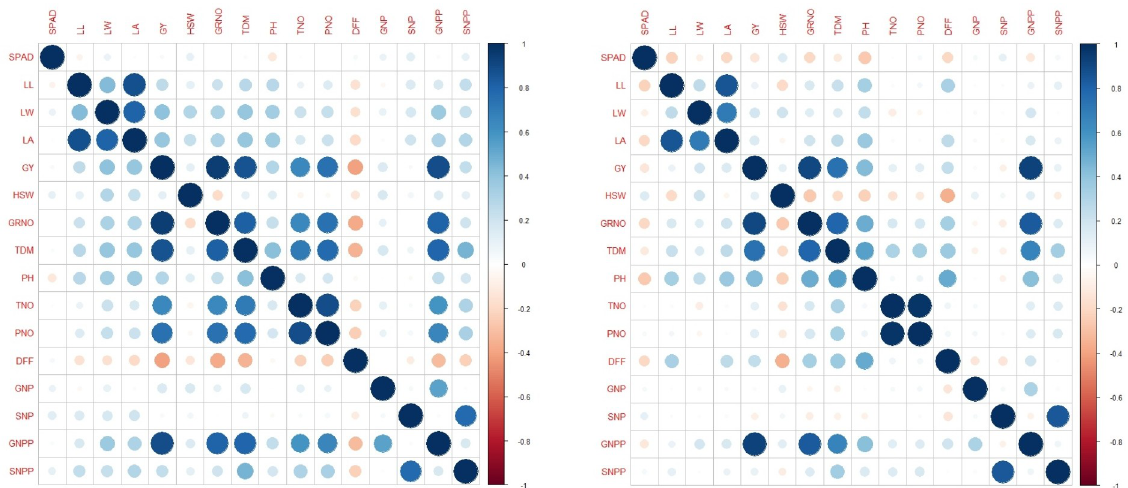
Fig 2. A. Correlation matrix under low N in wet season; B. Correlation matrix under low N in dry season. SPAD: SPAD value, LL: leaf length (cm), LW: leaf width (cm), LA: leaf area (cm), DFF: days to 50% flowering, PH: plant height (cm), TNO: tiller number, PNO: panicle number: GRNO: grain number, HSW: hundred seed weight (g), GY: grain yield per plant (g/plant), TDM: total dry matter (g/plant), GNP: grain nitrogen percent, SNP: straw nitrogen percent, GNPP: grain nitrogen/ plant, SNPP: straw nitrogen/ plant.